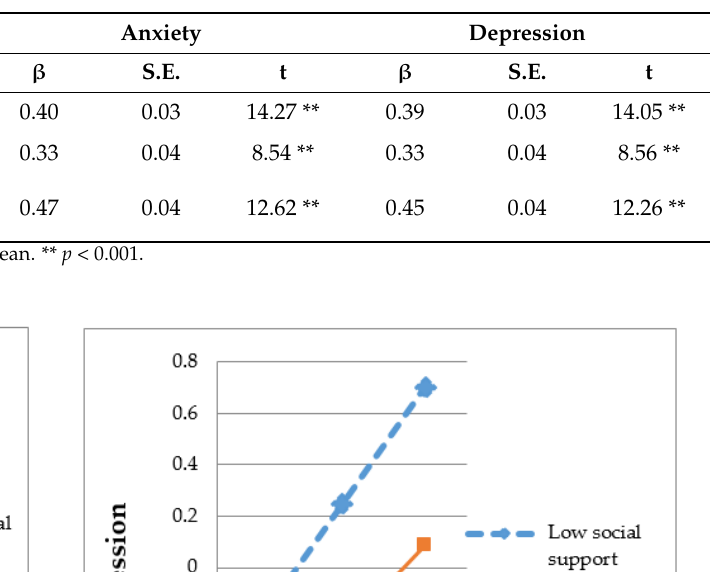
Table 5. Moderation Effect of Social Support.